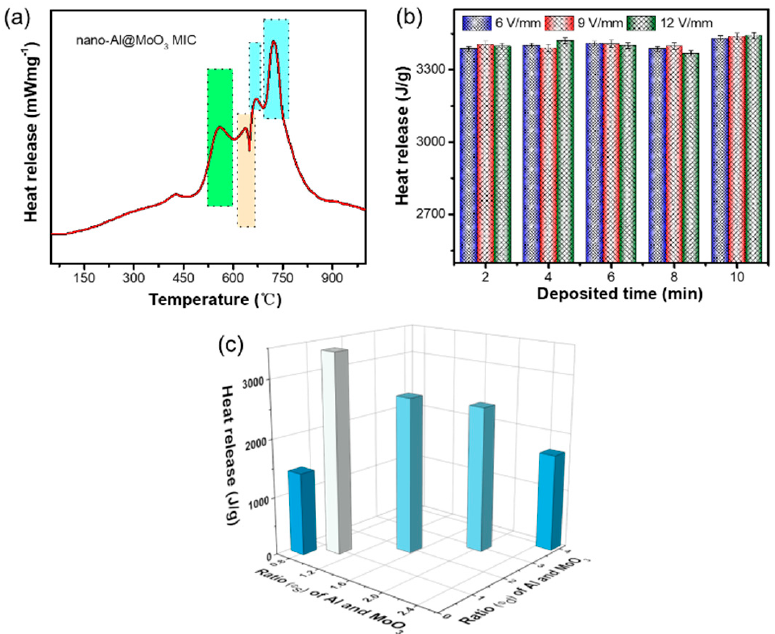
Figure 5. ( a ) Differential scanning calorimetry (DSC) curve of the obtained nano-Al/MoO 3 MIC; ( b ) the relationship of heat release and deposited time under different applied electric field strengths; and ( c ) 3D histogram of heat release as a function of Φ d and Φ s of Al and MoO 3 particles in the product.